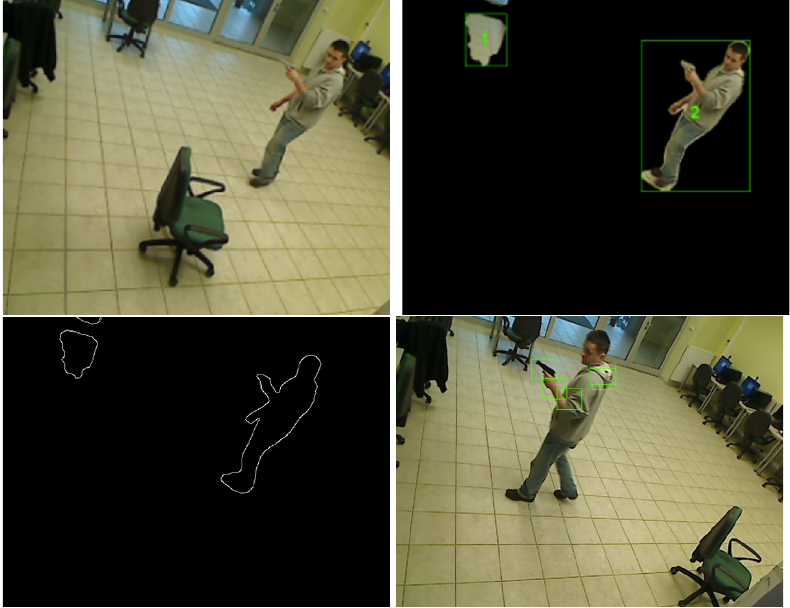
Figure 5. Image processed with background detection and Canny edge detection algorithms. ( a ) Input image; ( b ) Background detection; ( c ) Canny edge detection; ( d ) Neural network